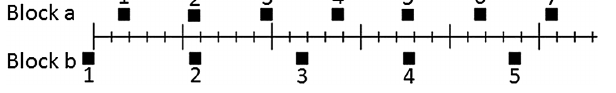
FIG. 5. Diagram for question 20.